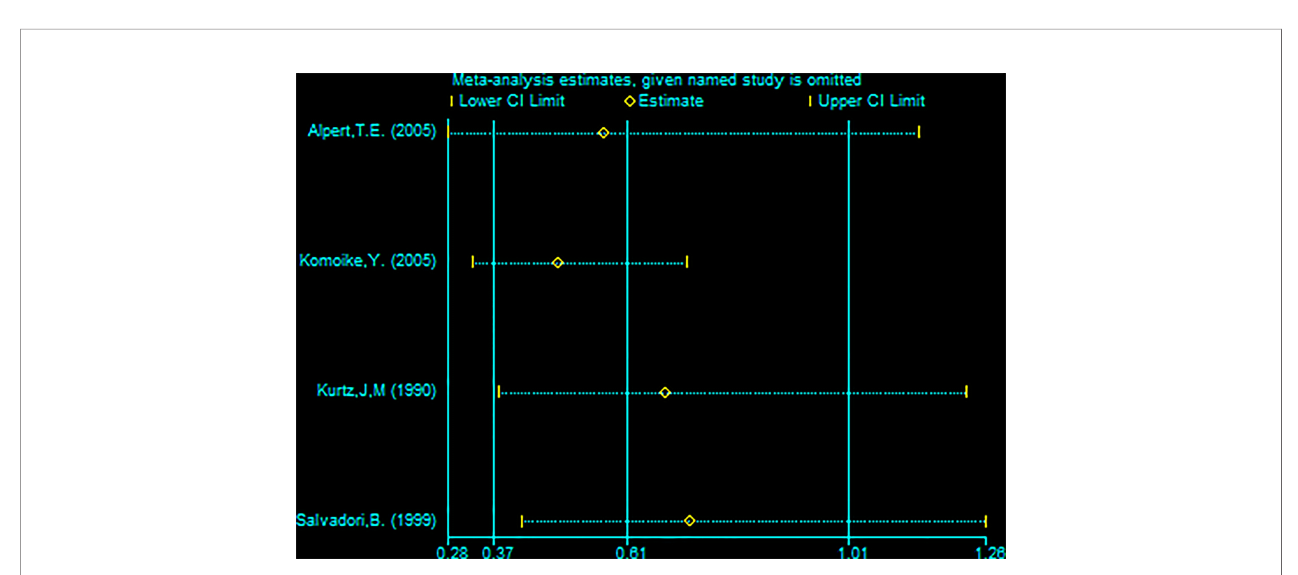
FIGURE 7 | Sensitivity analysis of meta-analysis of distant metastasis rate (DMR) by the method omitting one